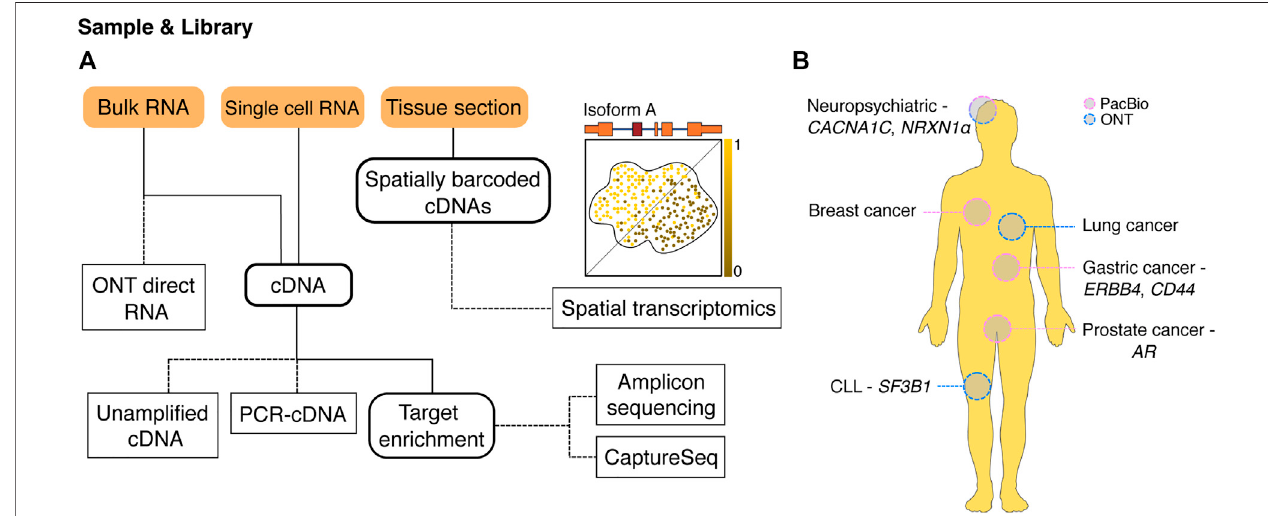
FIGURE1| Long-readmethodsforpro fi lingisoforms. (A) Anoverviewofavailablelong-readmethodologiesforisoformcharacterisation. Avarietyofsampleinputs (orange boxes) can be used with different sequencing methods (dashed edges) to answer a wide range of experimental questions. Intermediate experiment steps are shown with a bold outline. RNA from bulk samples can be either sequenced directly (ONT direct RNA) or reverse transcribed to cDNA, while RNA from single cells currently needs to be processed into cDNA before sequencing. Once present as cDNA, samples can be sequenced directly without PCR (unampli fi ed cDNA) or afterwhole-transcriptomePCRampli fi cation(PCR-cDNA)dependingonstartingamounts.cDNAcanalsoserveasinputfortargetenrichmenttechniquesincludingPCR forspeci fi cgeneisoformsofinterest(ampliconsequencing)orcaptureoftargetcDNAsforsequencing(CaptureSeq).Long-readspatialtranscriptomicsstartswithtissue sections placed on slides covered with spatially barcoded oligonucleotides. Cellular RNA is captured by nearby barcodes allowing generation of spatially barcoded cDNAs. Sequencing identi fi es spatial expression patterns of RNA isoforms within the tissue such as the hypothetical isoform A. (B) Selected examples where long-read sequencing methods have been used to examine isoforms and alternative splicing in a range of human diseases. AR, androgen receptor; CLL, chronic lymphocytic leukemia; PacBio, Paci fi c Biosciences; ONT, Oxford Nanopore Technologies.